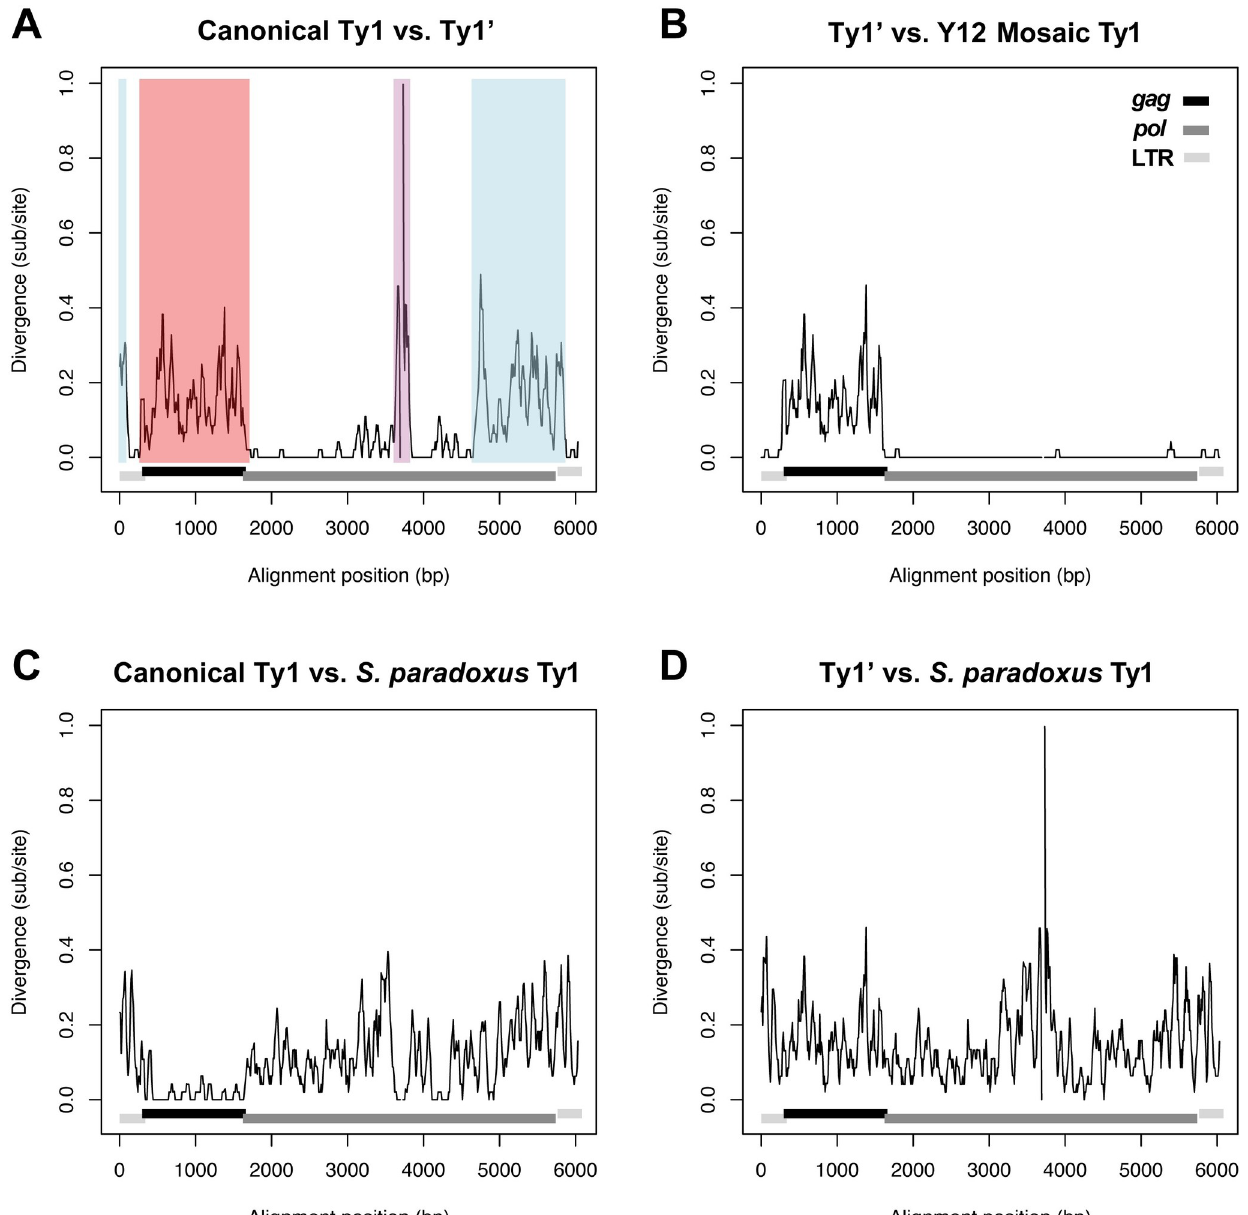
Fig 3. Sequence divergence between Ty1 elements in S . cerevisiae and S . paradoxus . Sliding window analysis of pairwise sequence divergence between ( A ) S . cerevisiae canonical Ty1 vs. S . cerevisiae Ty1’, ( B ) S . cerevisiae Ty1’ vs. S . cerevisiae mosaic Ty1 (found in the restrictive Y12 strain), ( C ) S . cerevisiae canonical Ty1 vs. S . paradoxus Ty1, and ( D ) S . cerevisiae Ty1’ vs. S . paradoxus Ty1. Functional regions of the Ty1 element are annotated as follows: LTRs (light grey); gag (black); pol (dark grey). Colored regions in ( A ) depict parts of Ty1 showing high divergence between S . cerevisiae canonical Ty1 vs. S . cerevisiae Ty1’. Blue: divergence in LTRs and pol caused by recombination between canonical Ty1 and Ty2 (see also [8,23] and S5 Fig); red: divergence in gag caused by recombination between canonical Ty1 and S . paradoxus Ty1; purple: divergence in pol caused by recombination between canonical Ty1 and S . paradoxus Ty1. Elements used are: DBVPG6044_f486 ( S . cerevisiae pure canonical Ty1); Y12_f208 ( S . cerevisiae pure Ty1’); Y12_f429 ( S . cerevisiae mosaic Ty1); CBS432_f139 (European S . paradoxus Ty1). Divergence measured in substitutions per site was calculated using a Kimura 2-parameter model in overlapping 50 bp windows with a 10 bp step